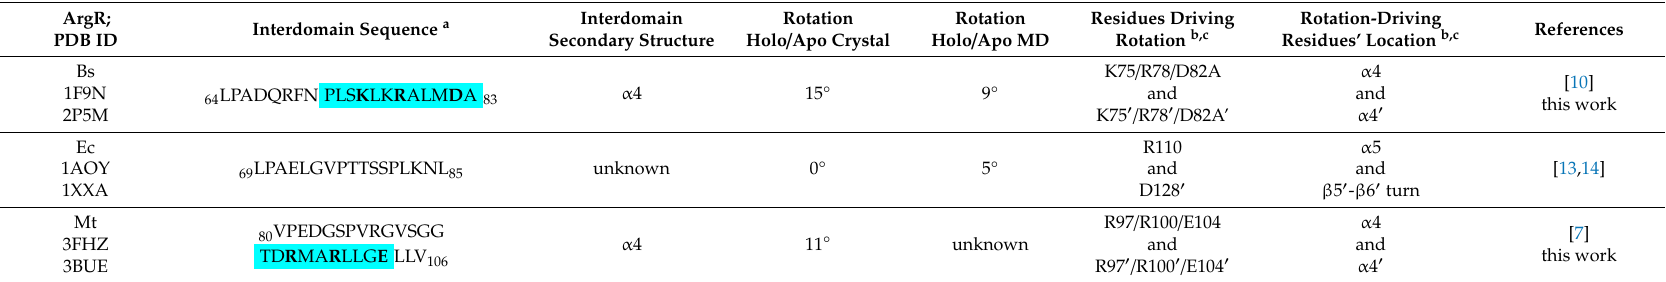
Table 1. ArgR interdomain and rotation-driving